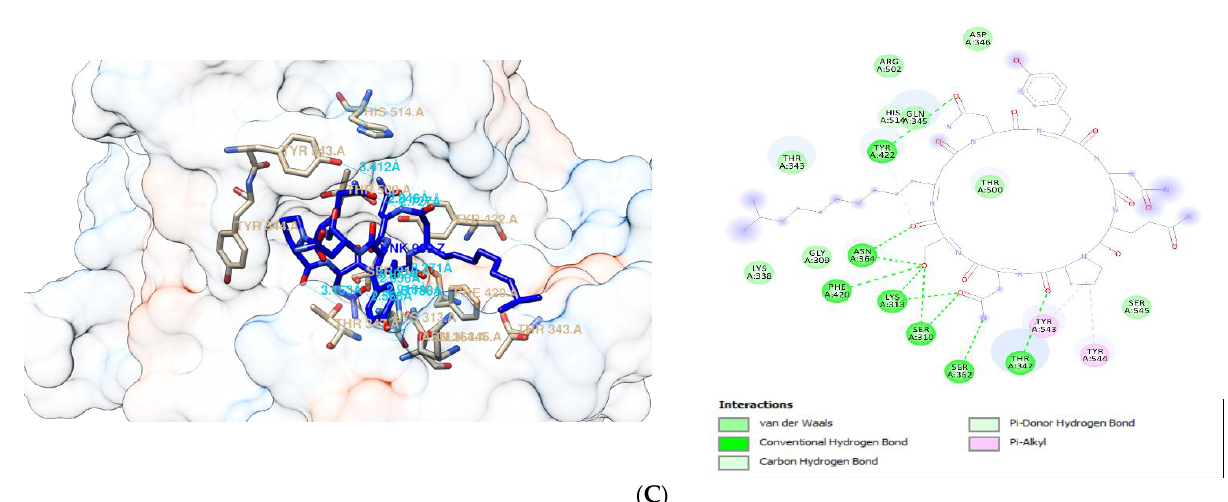
Figure 3. Molecular interaction between PBP2 with ( A ) fengycin, ( B ) surfactin, and ( C ) iturin A.